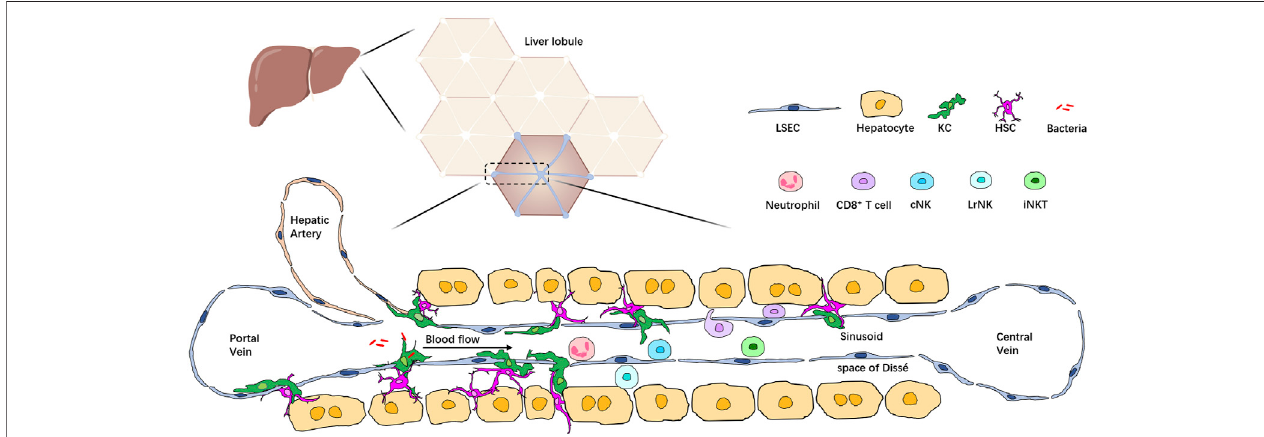
FIGURE 1 | Localization of multiple types of immune cells in the liver lobule. The liver comprises hexagonal units called lobules. Blood from the portal vein and hepaticartery fl owsthroughliversinusoidstothecentralvein.HepatocytesarearrangedaroundthesinusoidandformthespaceofDissé.KCsarelocatedinthespaceof Dissé and in close contact with HSCs, hepatocytes, and LSECs, allowing them to fi lter bacteria passing through the sinusoid. Immune cells such as neutrophils, T cells, iNKT cells, and conventional NK cells (cNK) are enriched in the hepatic sinusoids, patrolling the whole liver, whereas liver resident NK cells (LrNK) are located in the space of